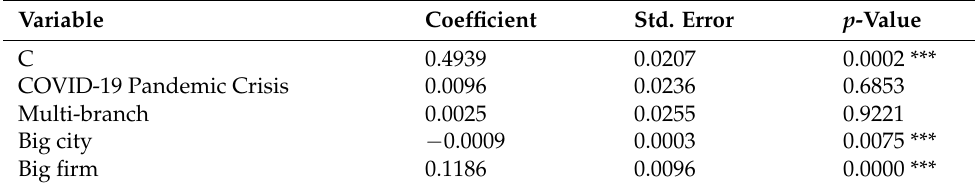
Table 9. The results of the eighth research